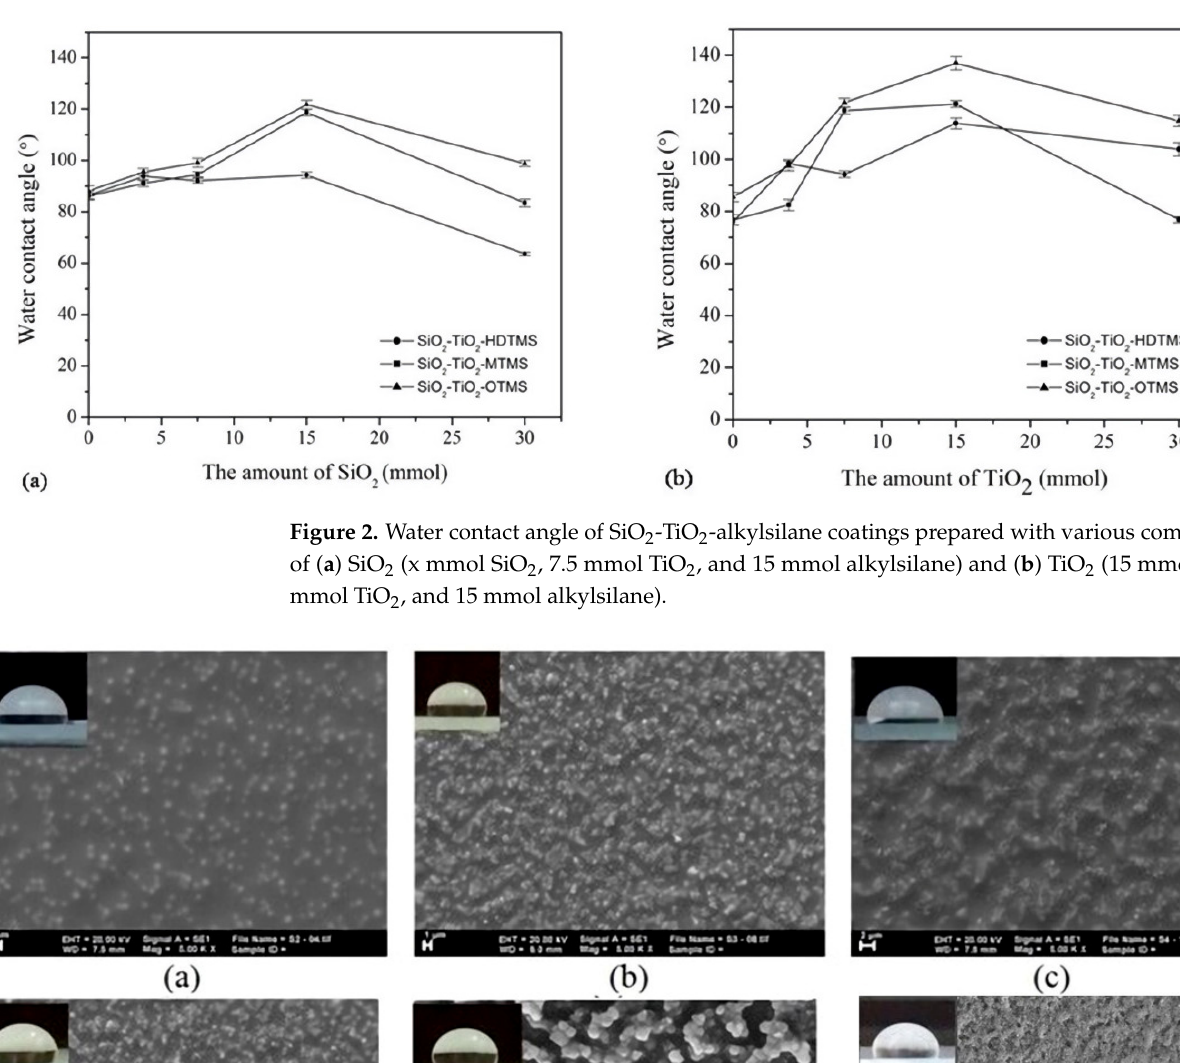
3400 cm − 1 1450 cm − 1